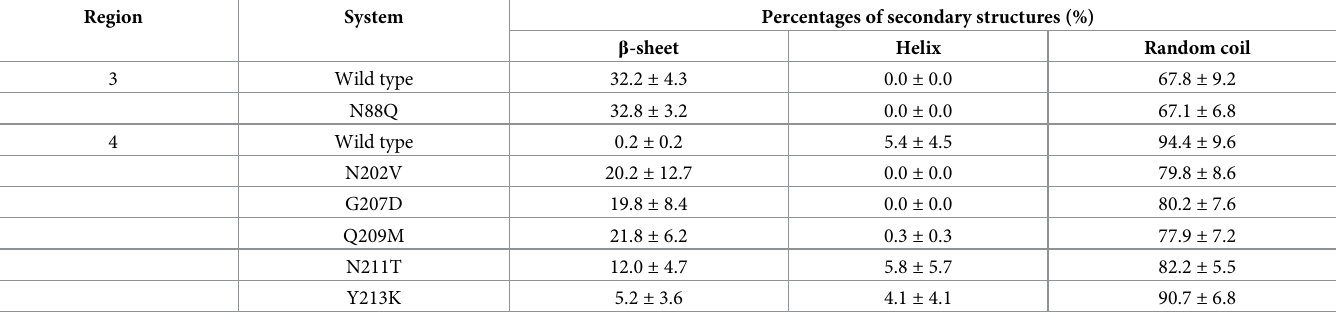
Table 4. Percentages of secondary structures of designed mutants, as calculated by Define Secondary Structure of Protein (DSSP).